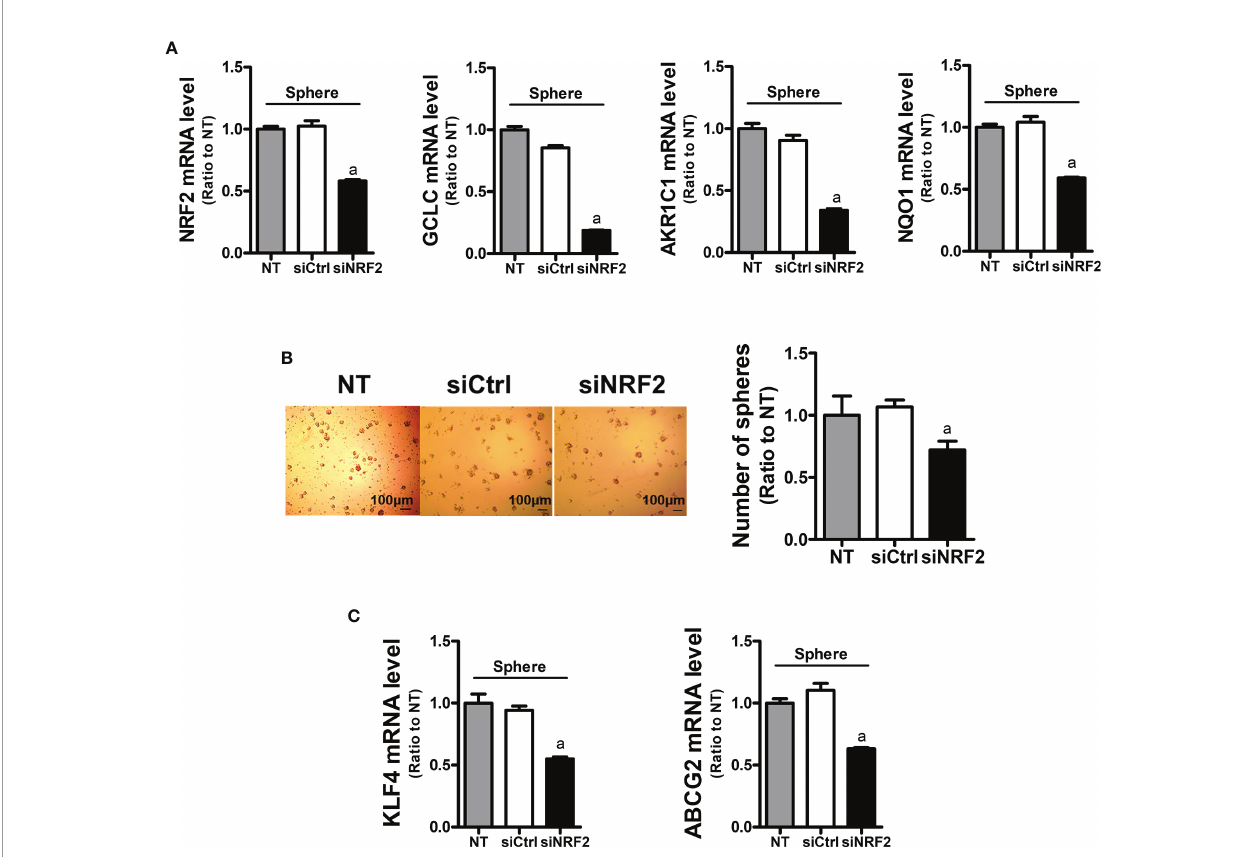
FIGURE 4 | Inhibition of sphere formation and CSC marker levels in NRF2 -silenced HCT116 cells. (A) HCT116 cells were transfected with the non-speci fi c siRNA (siCtrl) or NRF2 -speci fi c siRNA (siNRF2) and grown for 3 days in sphere culture condition. Levels of NRF2, GCLC, AKR1C1, and NQO1 mRNAs were determined in the siCtrl and siNRF2 spheres. a P < 0.05 compared to the siCtrl group. (B) The siCtrl and siNRF2 HCT116 were grown in sphere culture condition, and sphere formation was assessed. Number of spheres over 70 m m diameter was counted using an image processing ToupView software. Values represent the mean ± SEM from three independent experiments. a P < 0.05 compared to the siCtrl group. (C) Levels of KLF4 and ABCG2 mRNA were assessed in the siCtrl and siNRF2 spheres. a P < 0.05 compared to the siCtrl group. All values in RT-PCR analysis represent the mean ± SEM from at least three independent experiments. NT, non-transfection